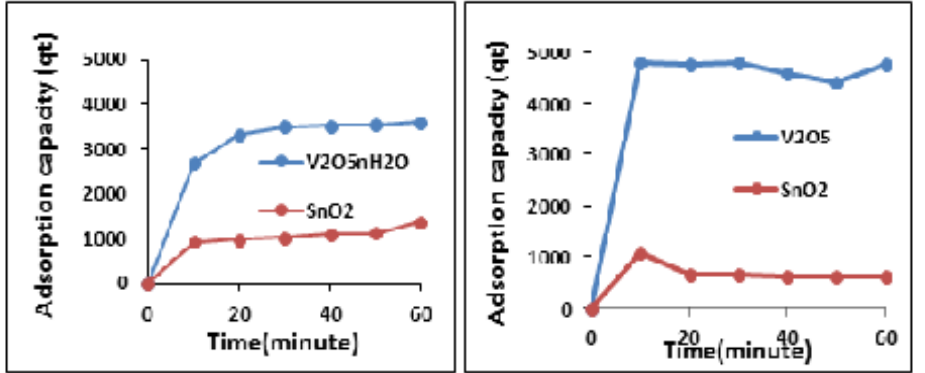
Figure (7): Adsorption capacity (q t ) of MB onto V 2 O 5 .nH 2 O and SnO 2 nanoparticles heating at 90 ◦ C and 500 ◦ C for 60 min)